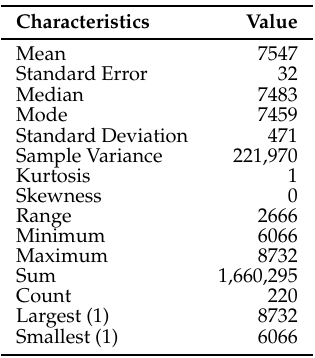
Table 7. Statistical characteristics of measured pressure force.